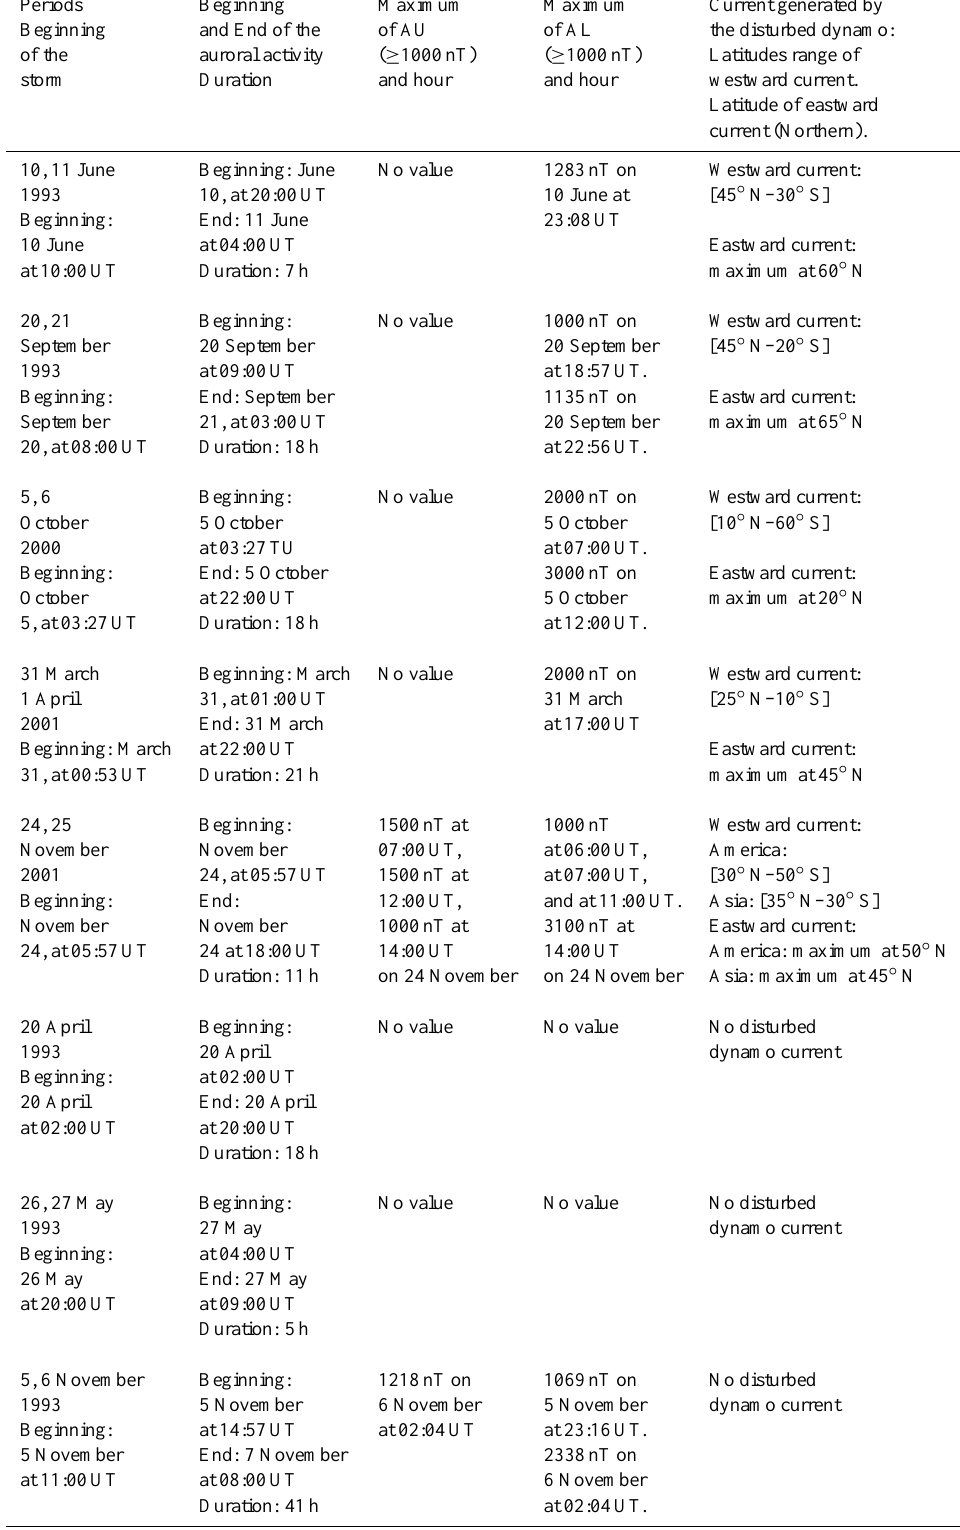
Table 3. Characteristics of the magnetic storms and currents induced at mid latitudes in the Northern Hemisphere and the equatorial